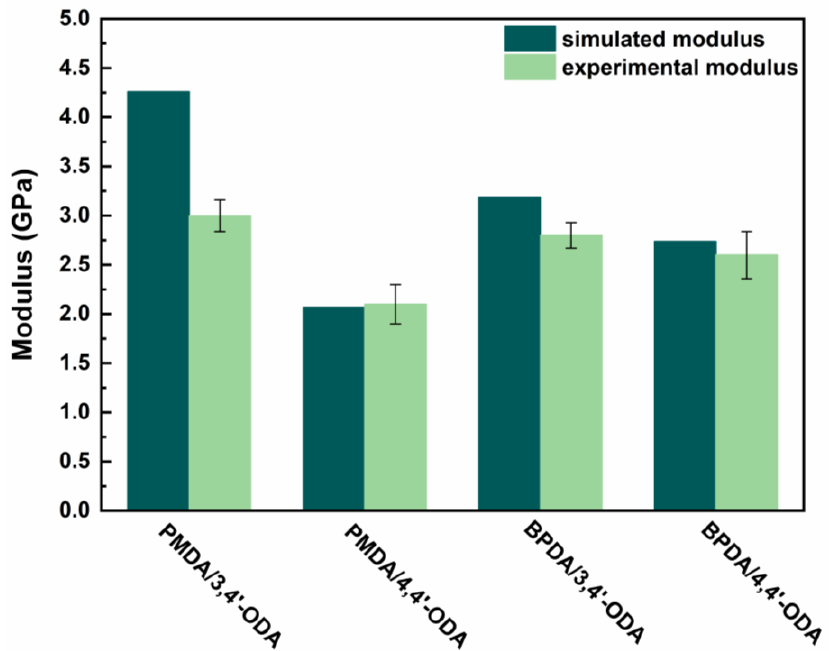
Figure 2. The modulus of different systems of polyimides.